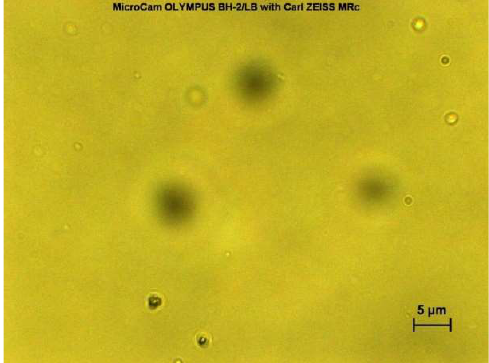
Figure 3. Microfluidic-prepared cinnarizine-containing niosomes comprised of Span® 60, cholesterol, and Cremophor® ELP.